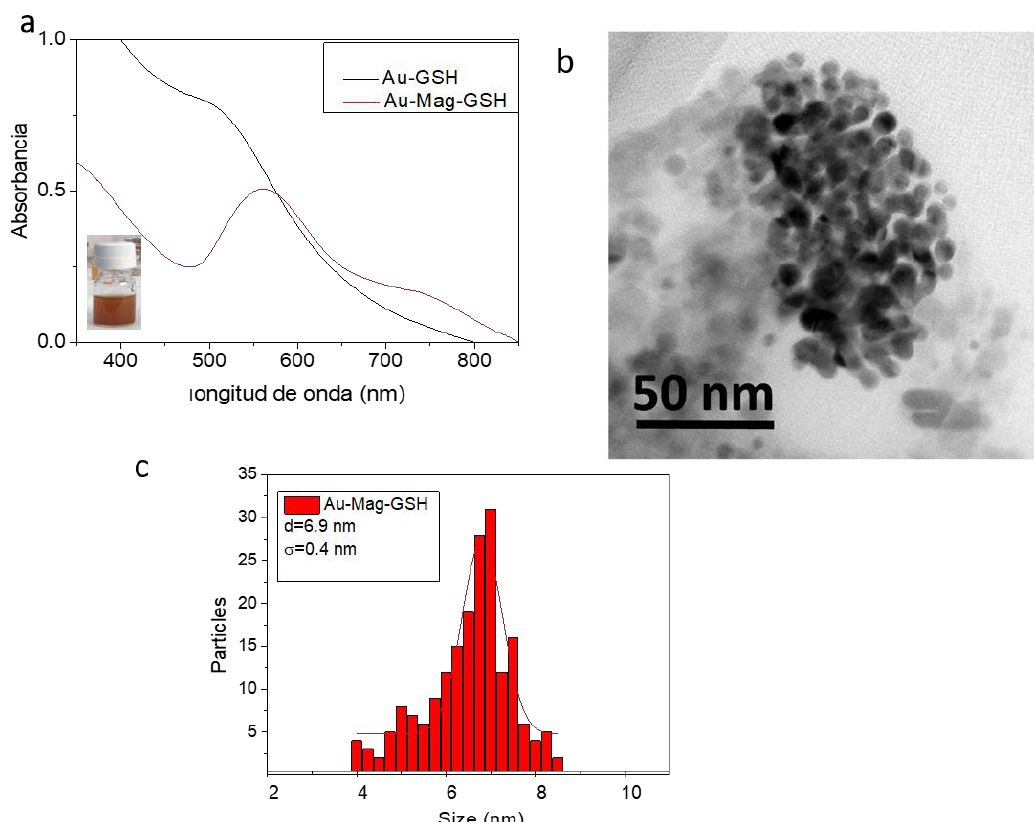
Figure 5. Ultraviolet (UV)–visible spectra for Au-GSH and Au-Mag-GSH colloidal solutions ( a ); TEM micrograph of Au-Mag-GSH ( b ) and its corresponding histogram displaying NP size distribution ( c ).